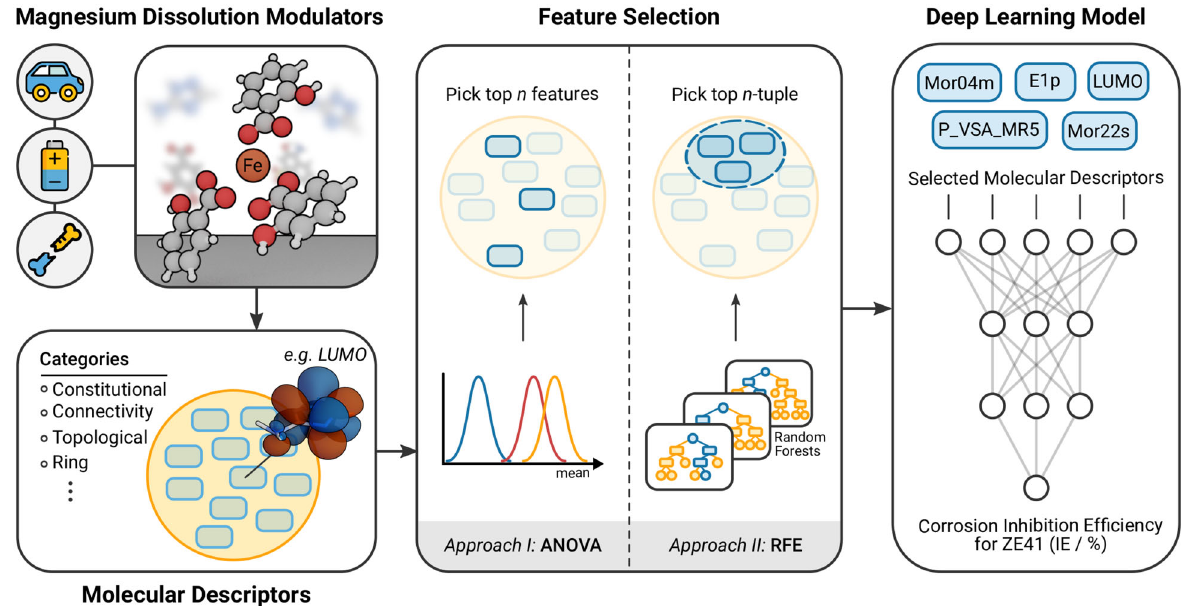
Fig. 1 Work fl ow overview. Our overarching objective is the prediction of the magnesium corrosion inhibition ef fi ciency of different molecular dissolution modulators. To this end, fi rst relevant molecular features are selected either by (approach I) analysis of variance (ANOVA) or by (approach II) recursive feature elimination based on random forests (RFE), a type of machine learning. The best-performing feature set de fi nes the input for a deep learning model. This model allows the desired predictions of quantitative structure-property relationships (QSPR) for the ef fi ciency of magnesium dissolution modulators, in our study speci fi cally for the magnesium alloy